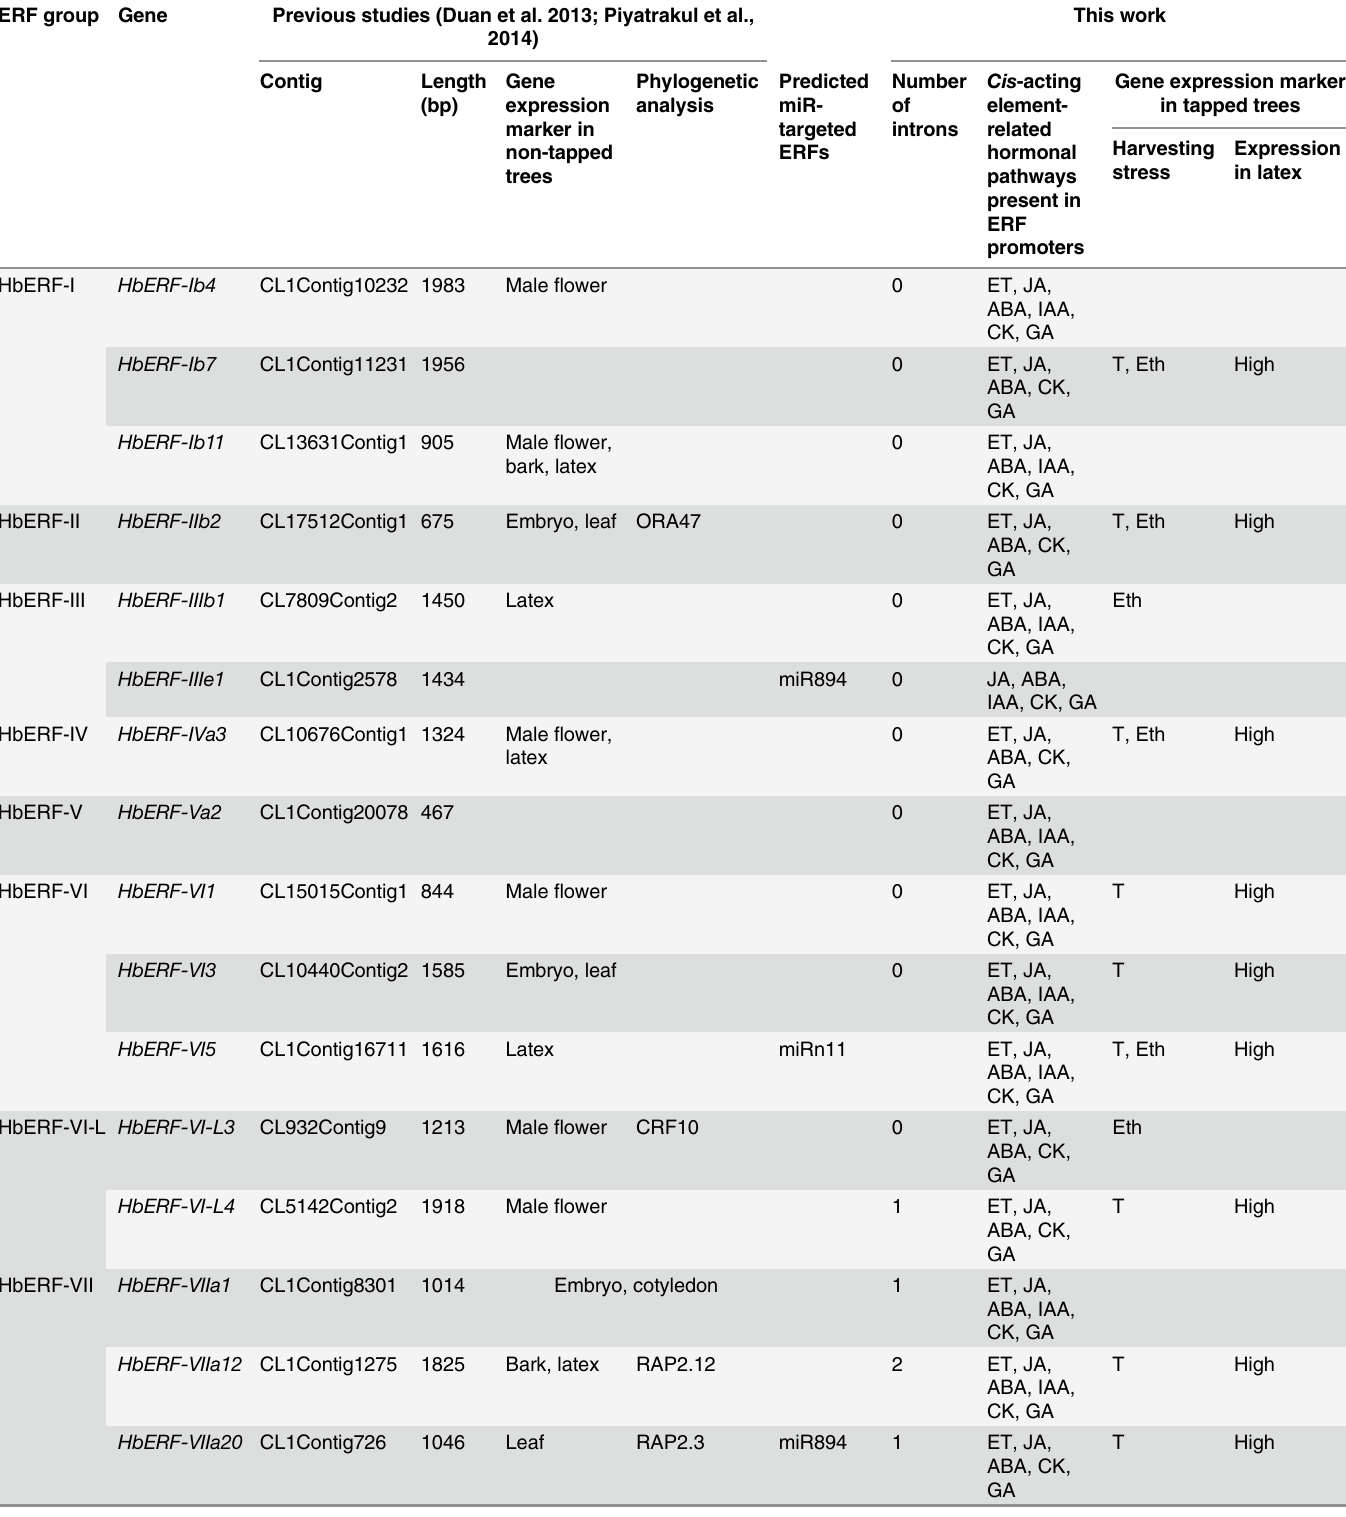
Table 1. Summary of 35 Hevea brasiliensis ERF genes tested in response to harvesting stress in bark and latex